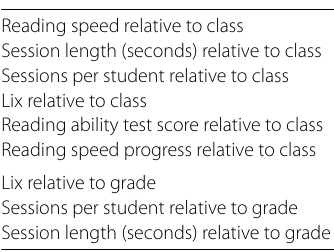
Table 4 List of peer